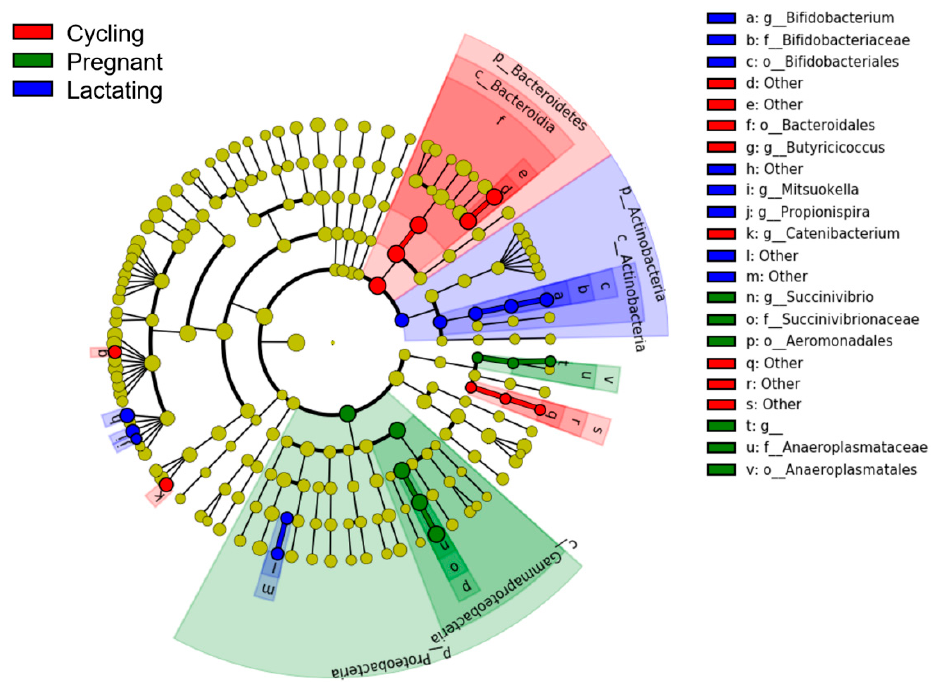
Figure 4. LEfSe analysis on the gut microbial taxonomy of three reproductive states. Gut microbial taxonomy enriched in different reproductive states identified by linear discriminant analysis coupled with effect size (LEfSe) (LDA > 2, p < 0.05).